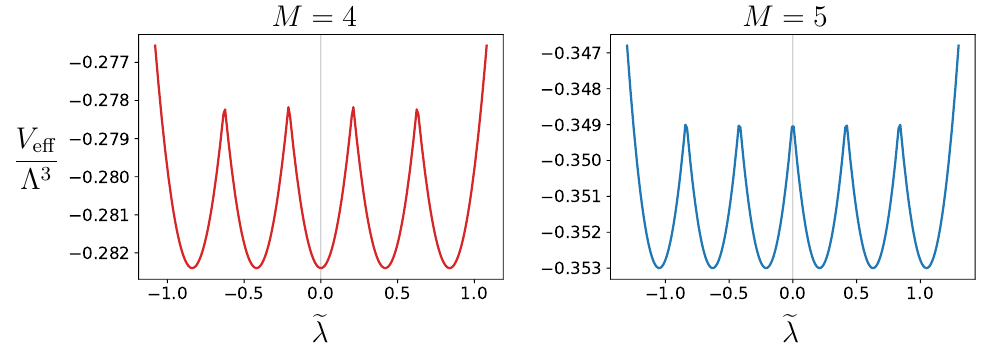
Figure 2 . The ground state energy density for